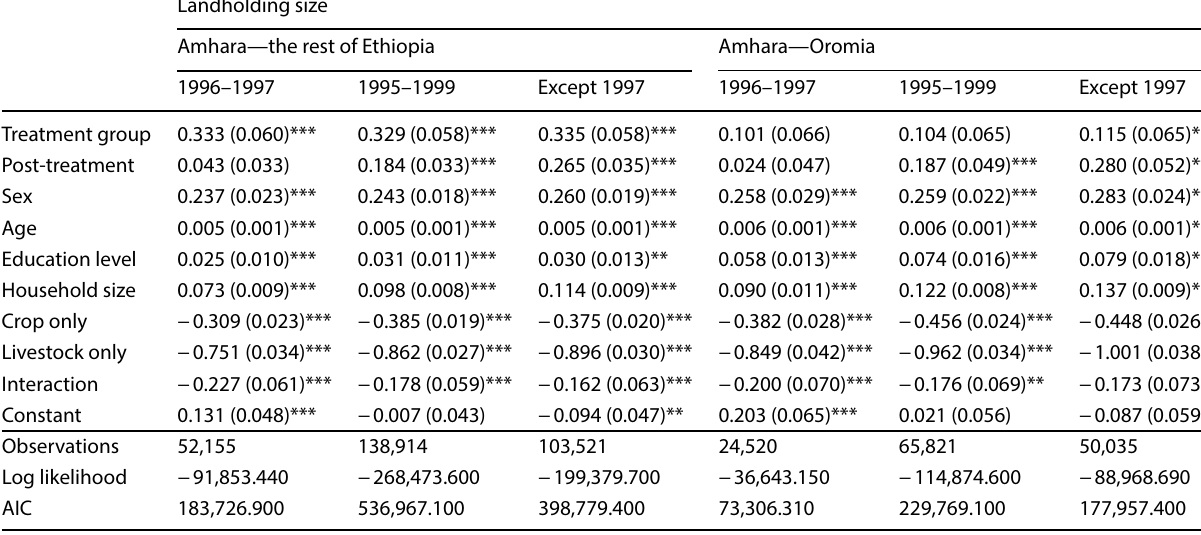
Cluster robust standard errors in